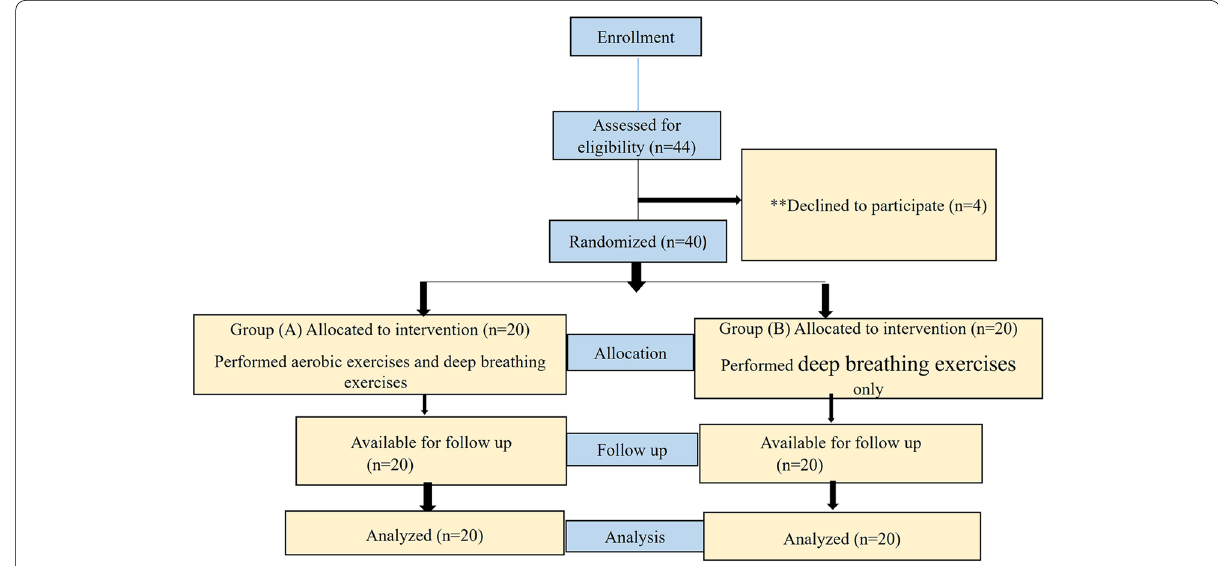
Fig. 1 CONSORT flow chart for the participants in the